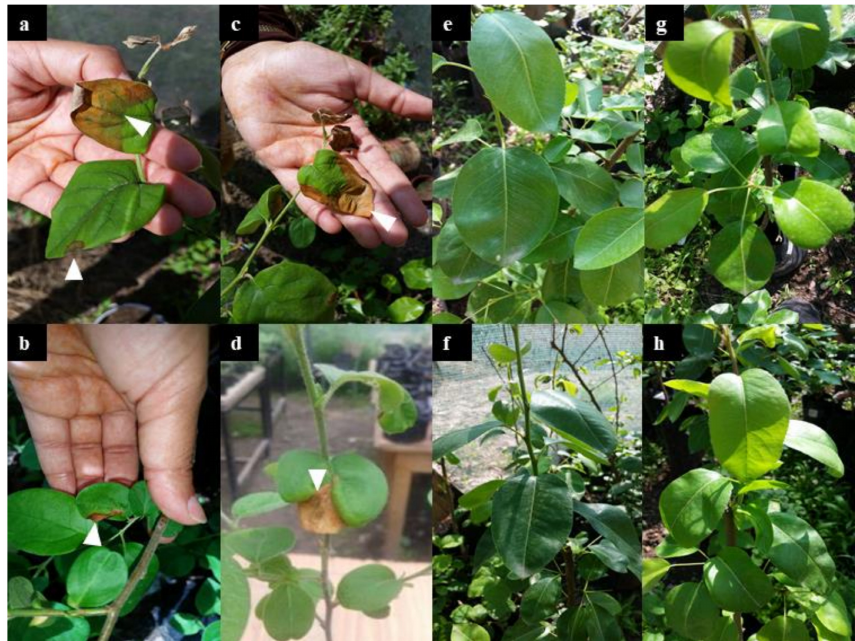
Figure 1. Pathogenicity tests on pear plants grown in greenhouse after fifteen days of inoculation. For Louise bonne cultivar exposed to B10 isolate, panels ( a , c ) represent symptoms developed using the spray method, ( b , d ) symptoms observed by the infiltration method. Panel ( e ) shows no symptoms on Williams cultivar inoculated with B10 isolate, ( f ) shows no symptoms on control plants of Williams cv and ( g , h ) shows no symptoms on leaves inoculated by other isolates (B13 and B2) on Louise bonne cultivar.